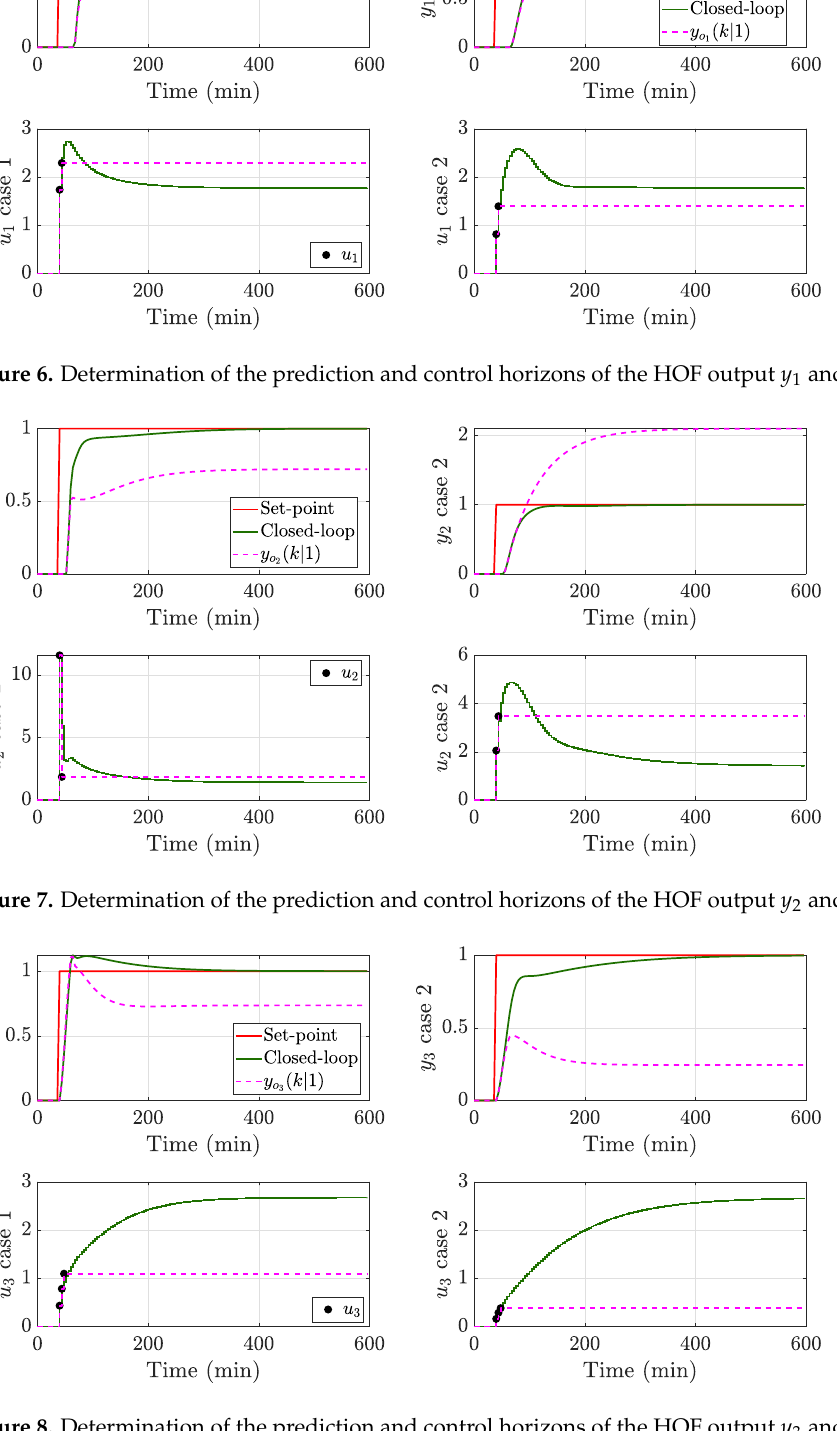
Figure 8. Determination of the prediction and control horizons of the HOF output y 3 and input u 3